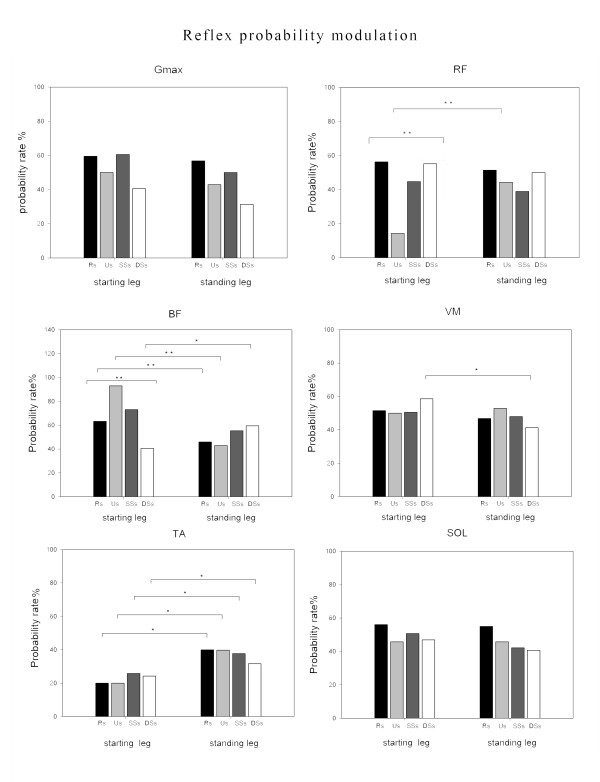
Raw EMG data of the biceps femoralis muscle showing the NWR at the different phases of gait initiation in a representative subject. Dotted lines indicate the stimulus delivery. Arrows indicate the reflexes. Note the higher size values in the unloading (Us) and single support (SSs) subphases.